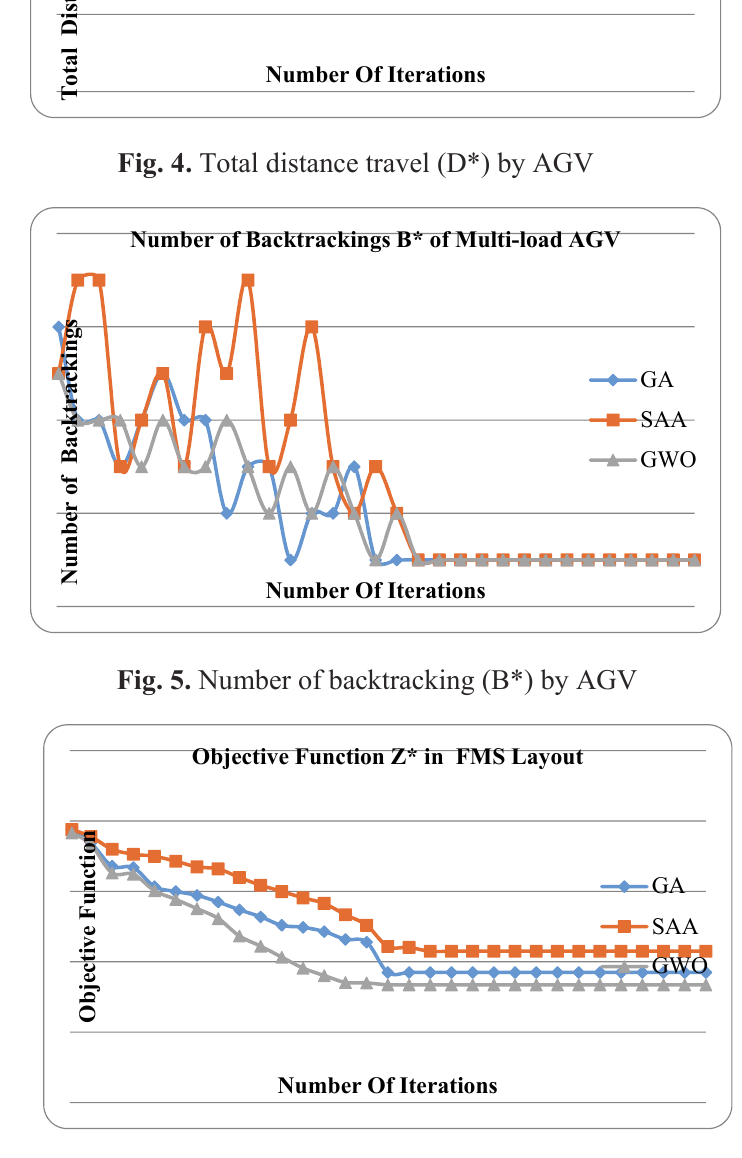
Fig. 6. Objective function (Z*) by